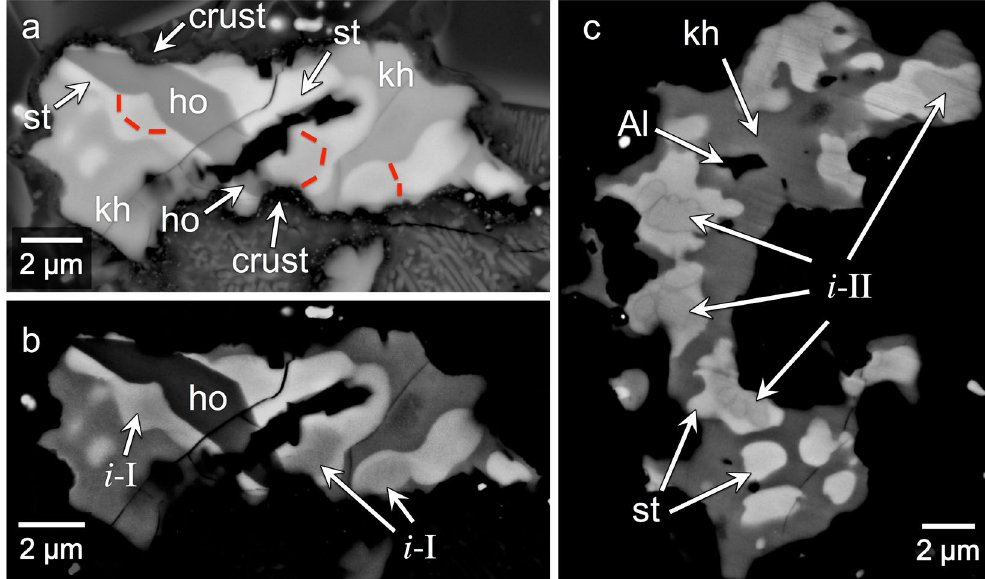
Figure 4. BSE images of Al-Cu-Fe assemblages with two generations of quasicrystals. Compositions for the metal phases shown here are listed in Table 1. Contrast in ( b ) and ( c ) has been stretched to emphasize compositional differences among the different metal phases. ( a , b ) Close up of Location 8 (Fig. 2a). This assemblage contains khatyrkite (“kh”), stolperite (“st”), hollisterite (“ho”), and icosahedrite (“ i -I”). The red, dashed lines in ( a ) outline the icosahedrite grains to distinguish these grains from the neighboring phases; these sketches of the phase boundaries are based on higher contrast images of the same region, such as shown in ( b ). The upper and lower ends of the hollisterite grain terminate against the spinel crust (“crust”). We interpret this as a cross-cutting relationship that indicates the hollisterite and i -I are relict. The dark area in the center of the Al-Cu-Fe assemblage is a hole. ( c ) Close up of Location 10 (Fig. 2a). This assemblage contains quasicrystals (“ i - II”) that are distinct from i -I. Surrounding i -II is stolperite, which is surrounded by khatyrkite. The dark area in the interior of this assemblage is metallic Al (“Al”). The dark area external to this assemblage contains silicate phases, which are not discernable in this image because of the high